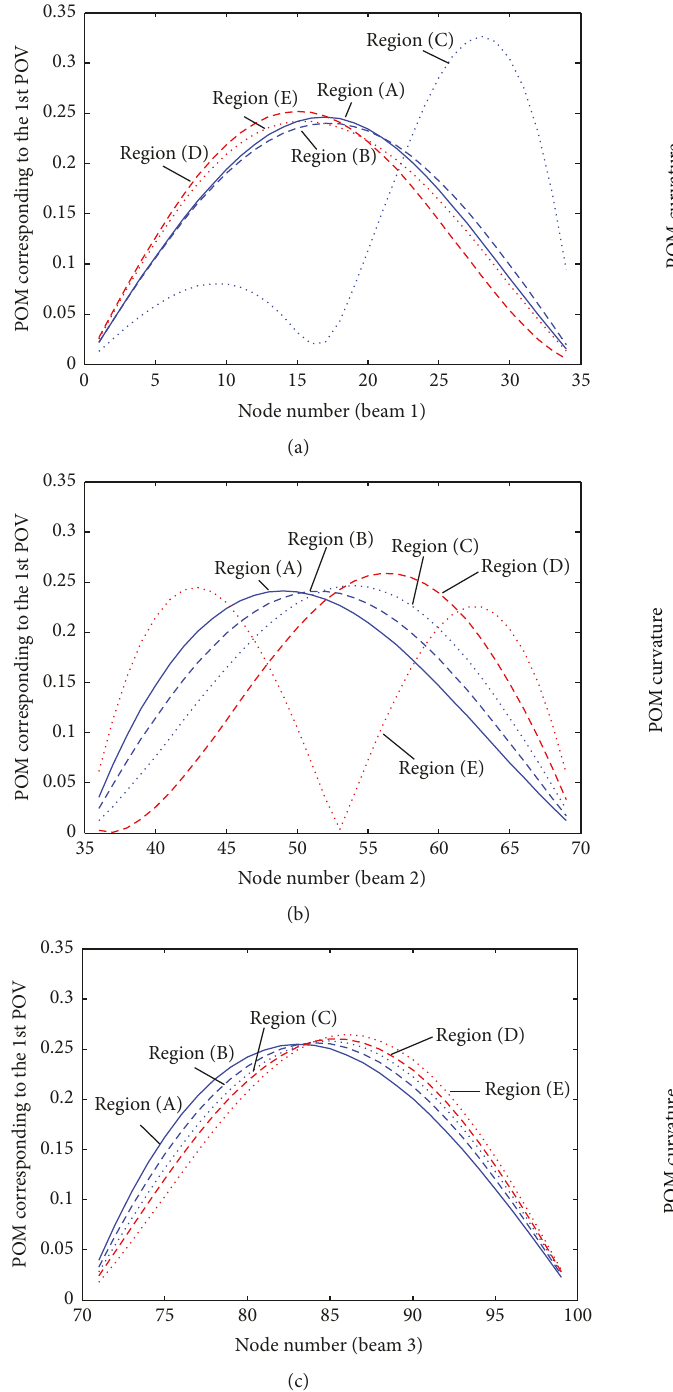
Figure 4: POM curves using noise-free FRFs within the five different frequency ranges: (a) beam 1, (b) beam 2, and (c) beam 3. of beam 2. It is shown that the peak of the curves moves little by little to the right with the increase of the frequency region to extract the FRF data except the POM curve corresponding to region (E). Figure 4(c) exhibits the POM curves of beam 3. The peak of the curves moves little by little to the right